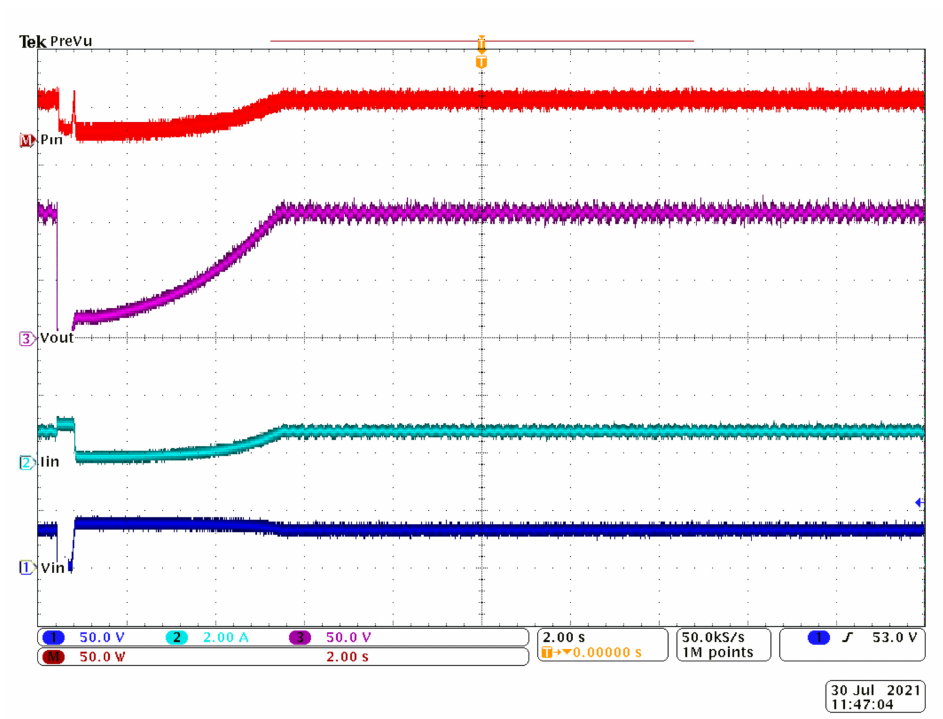
Figure 29. Oscilloscope waveforms at start-up for: input voltage “ Vin ” (dark-blue), input current “ Iin ” (cyan), output voltage “ Vout ” (purple), and input power “ Pin ” (red), in down to up order.